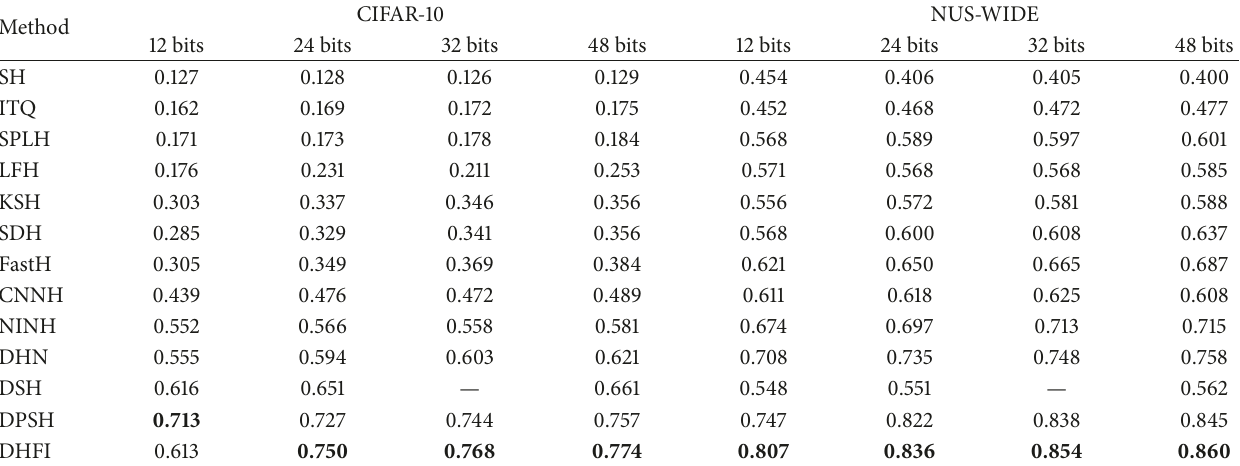
Table 2: Accuracy in terms of MAP compared to hashing methods.